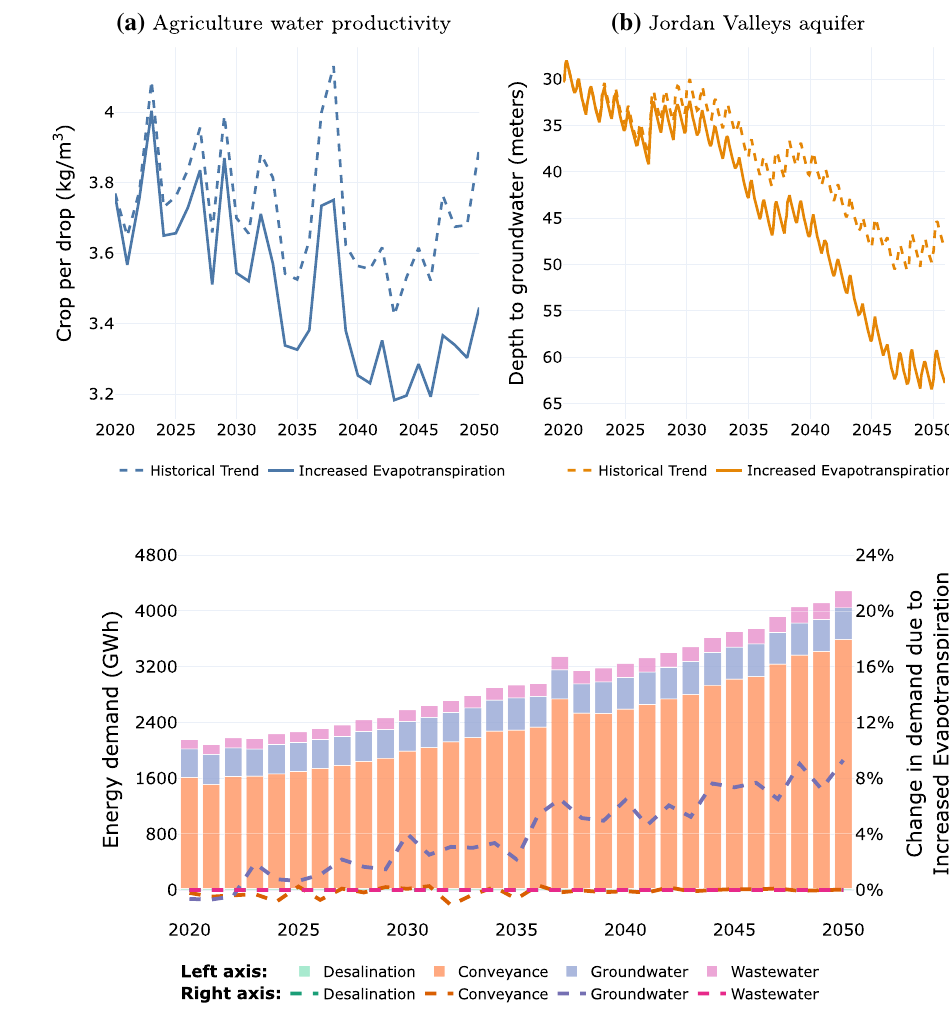
Fig. 4 No Intervention scenario under two climate futures results for: a Crop production per unit of water irrigated (kg/m 3 ); and b Aqui- fer drawdown of the Jordan Valleys aquifer